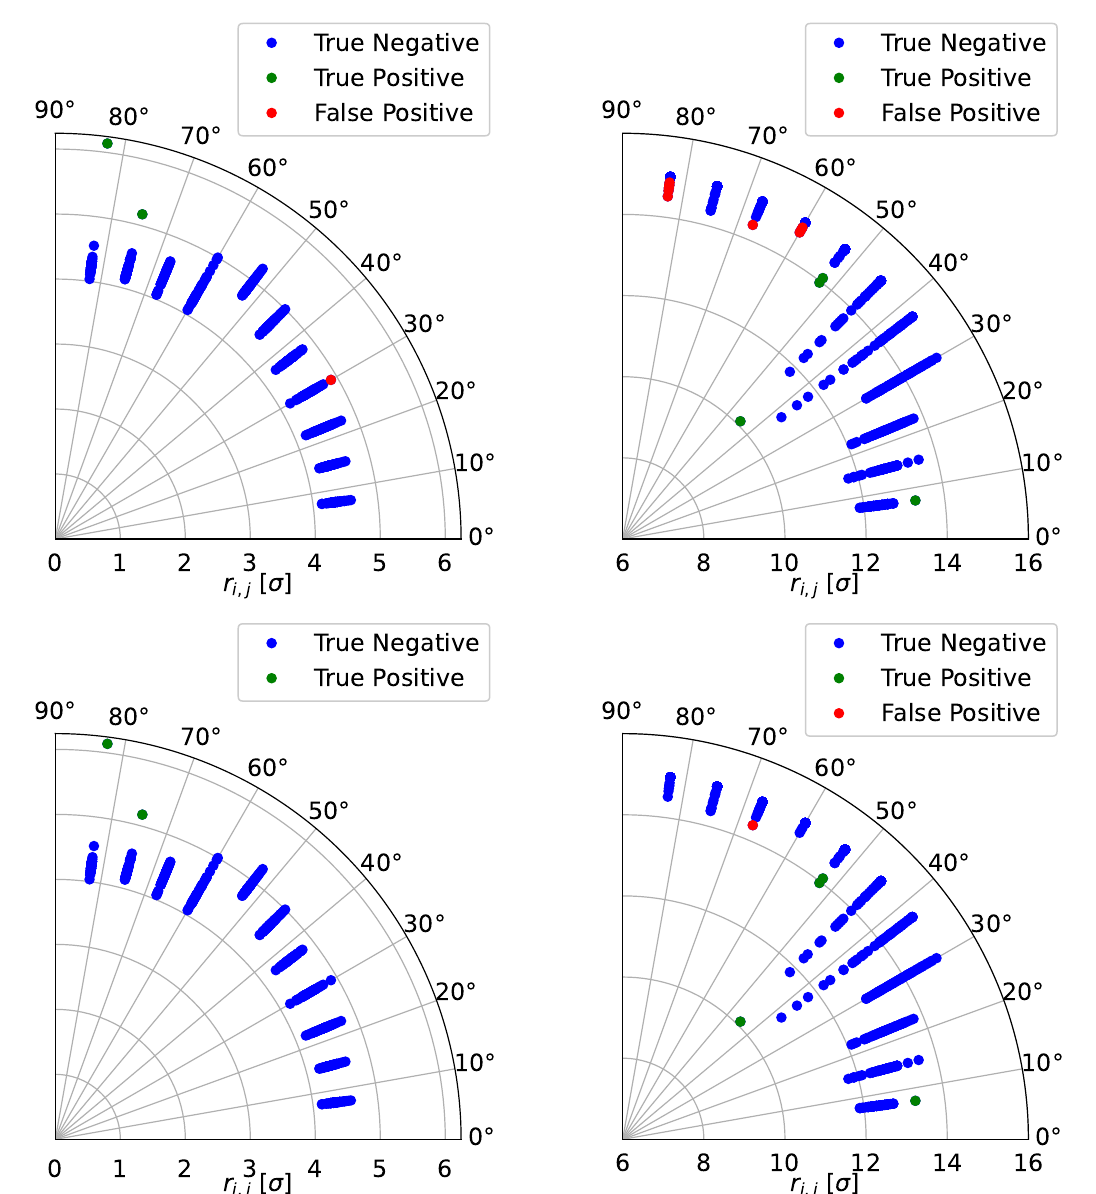
Figure 2. ( Top row ): DA simulations for two LHC configurations. The initial 4D coordinates are of the type ( x ,0, y ,0 ) and a polar scan was performed on ( x , y ) . The markers represent the results of the sixty seeds used. Left: Example of a DA computation where two outliers are correctly flagged (in green). Right: Examples of a false positive (in red). Note that the FP cases concerning outliers from above are less worrisome as they refer to the determination of the maximum stable amplitude, which does not affect DA min . ( Bottom row ): same, but after applying the post-processing, which shows the improvement on the outlier